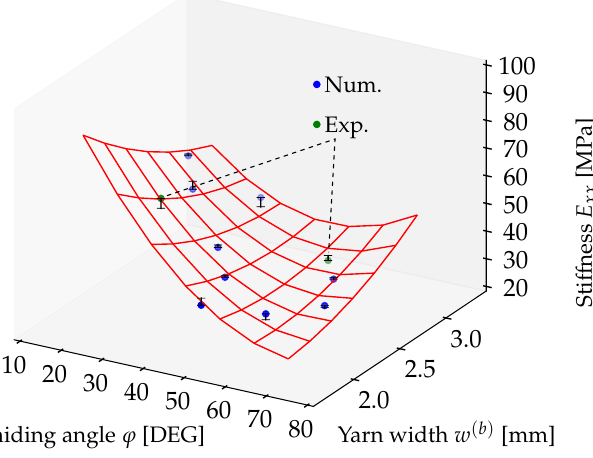
Figure 5. Stiffness E xx over braiding angle and yarn width